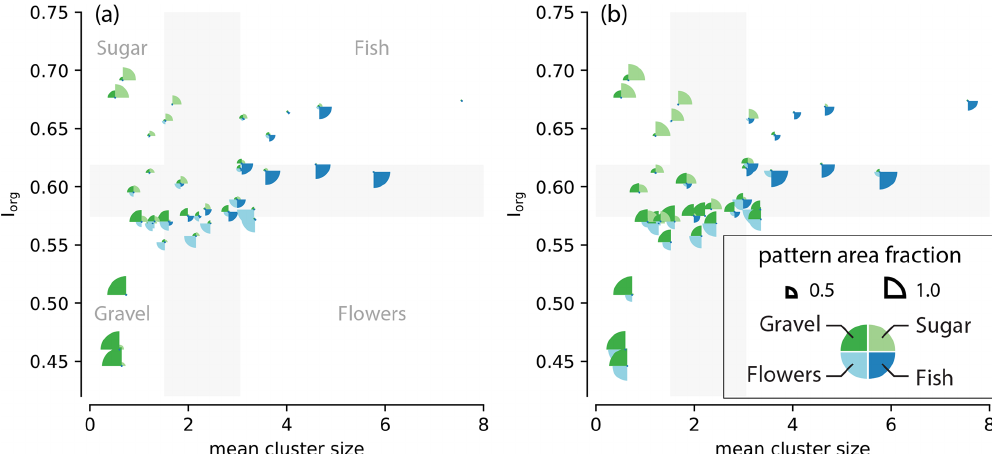
Figure 6. Comparison of the I org versus mean cluster size ( S ) classification method and the (a) manually classified patterns and (b) the neural network classifications. For each I org /S classification, the manually/automatically classified pattern area for each pattern is indicated as wedges of different sizes. Mean cluster size is given as a fraction of the domain size and multiplied by 10 4 to be consistent with Bony et al. (2020). Grey areas indicate the middle terciles of I org and S and are the bounds of the four pattern quadrants. All classifications are based on the GOES-16 ABI infrared images and are daily averages.